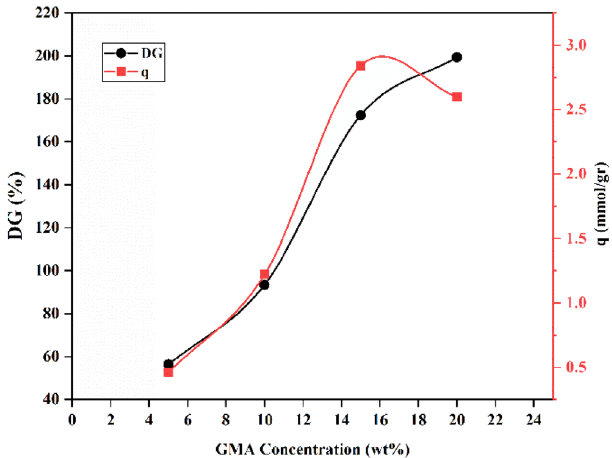
Figure 6. Effect of GMA concentration on (DG%) and adsorption capacity (q).